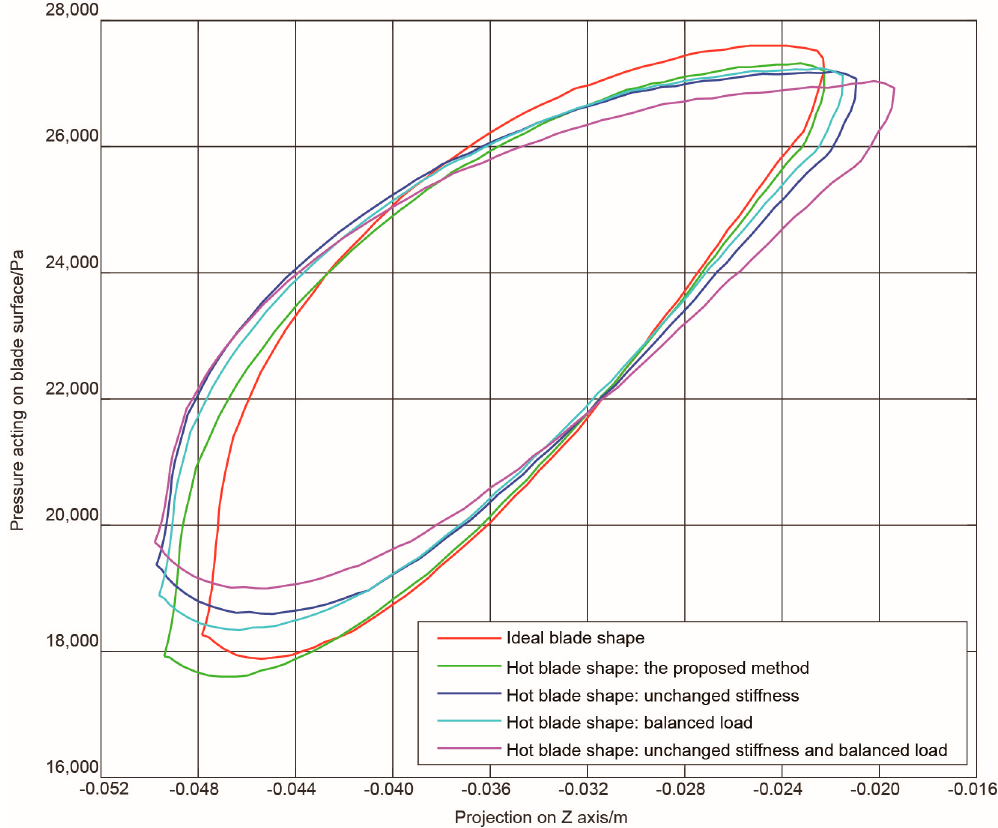
Figure 12. Pressure curves of the cross-sectional edge at 95% of the blade height.